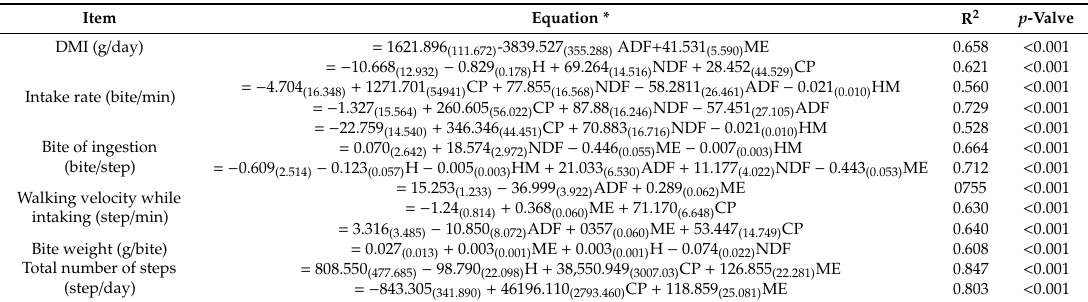
Table 4. Linear prediction of grazing behavior of Tibetan sheep using plant community characteristics and chemical composition of forage and forage chemical composition